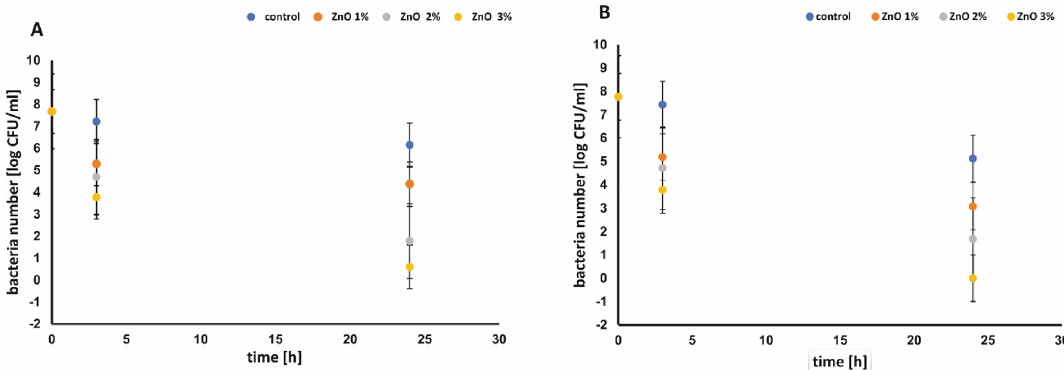
Figure 8. The antibacterial effects of functionalization of cellulose fibers with varied amount of ZnO E. coli ( A ), S. epidermidis ( B ).